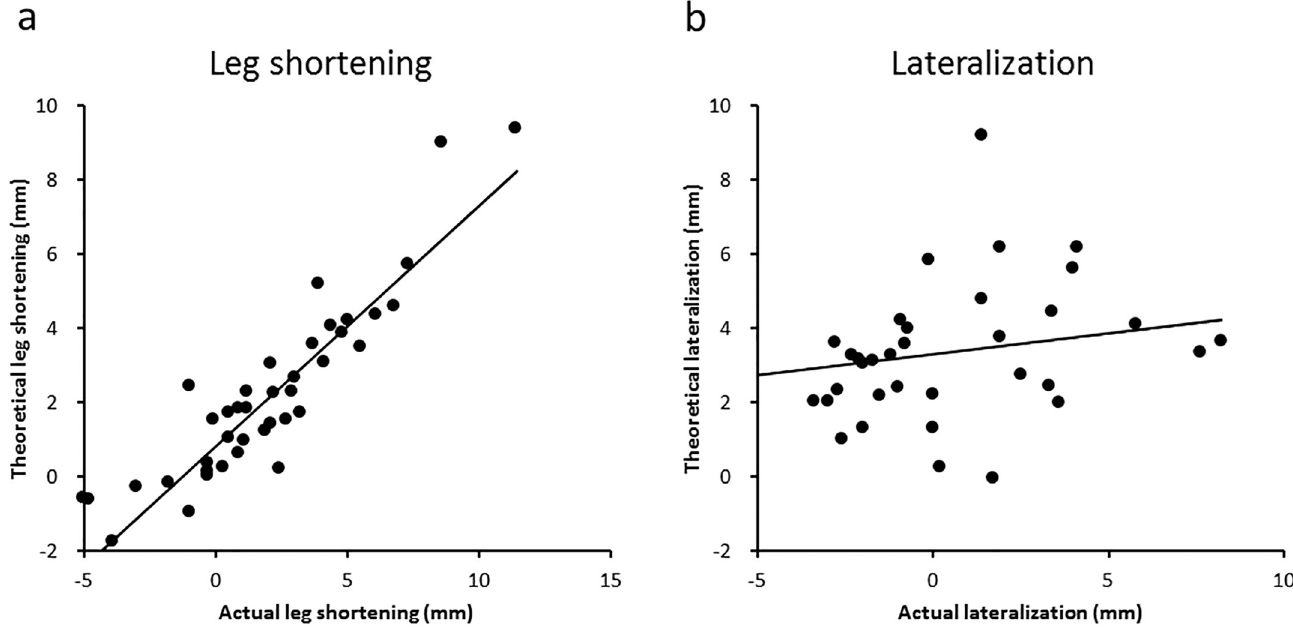
Fig 6. Correlation of the actual and theoretical changes after curved intertrochanteric varus osteotomy. a) Correlation of the actual and theoretical leg shortening and b) correlation of the actual and theoretical lateralization are shown.